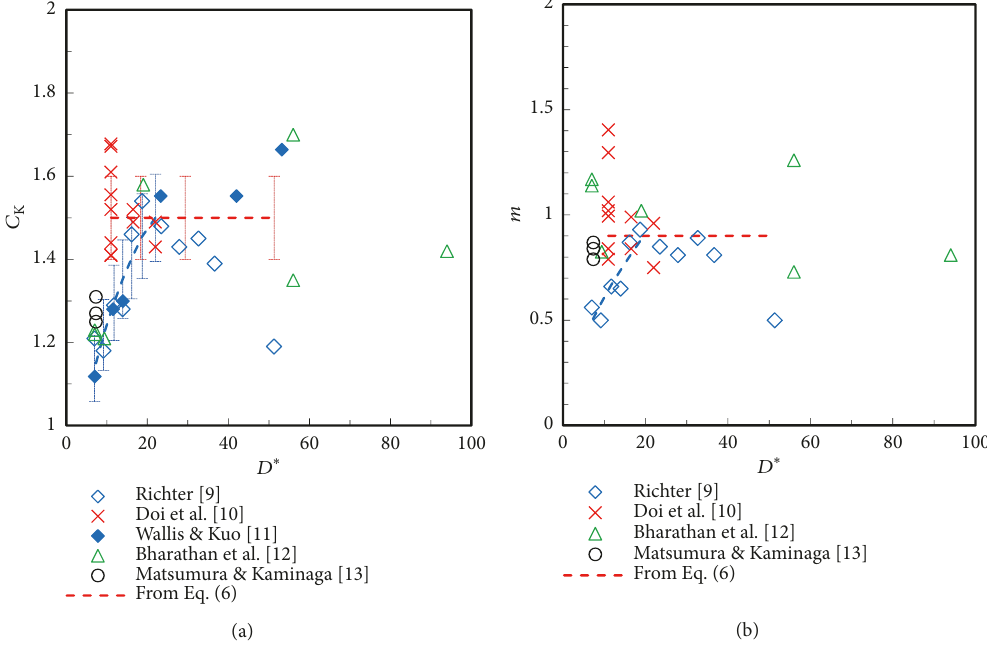
Figure 7: CCFL characteristics at the square top end: (a) CCFL constant 𝐶 K and (b) slope m